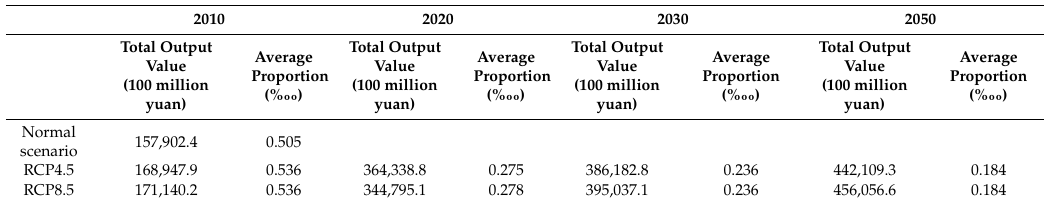
Table 4. Industrial output values and their proportions from 2010 to 2050 under scenarios RCP4.5 and